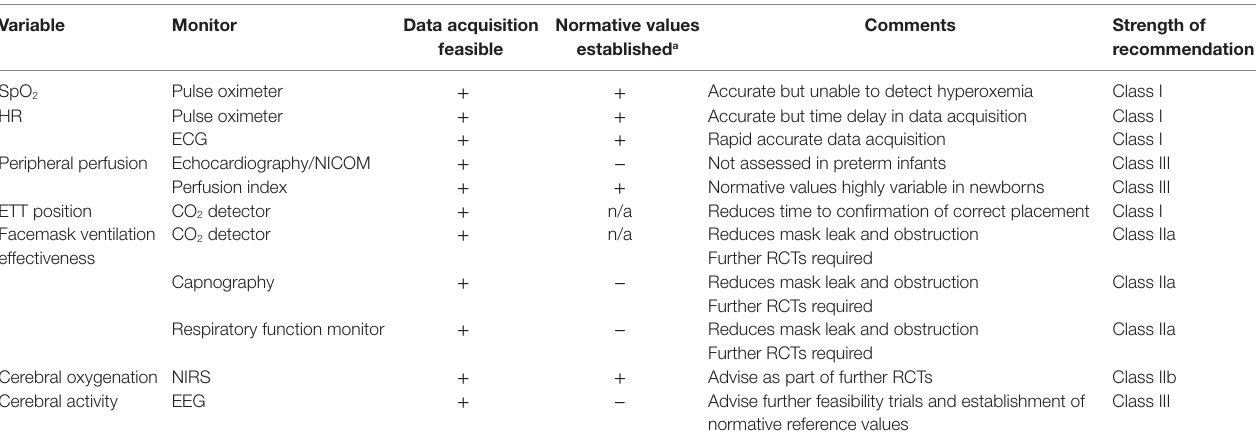
TABLe 1 | Summary of monitoring